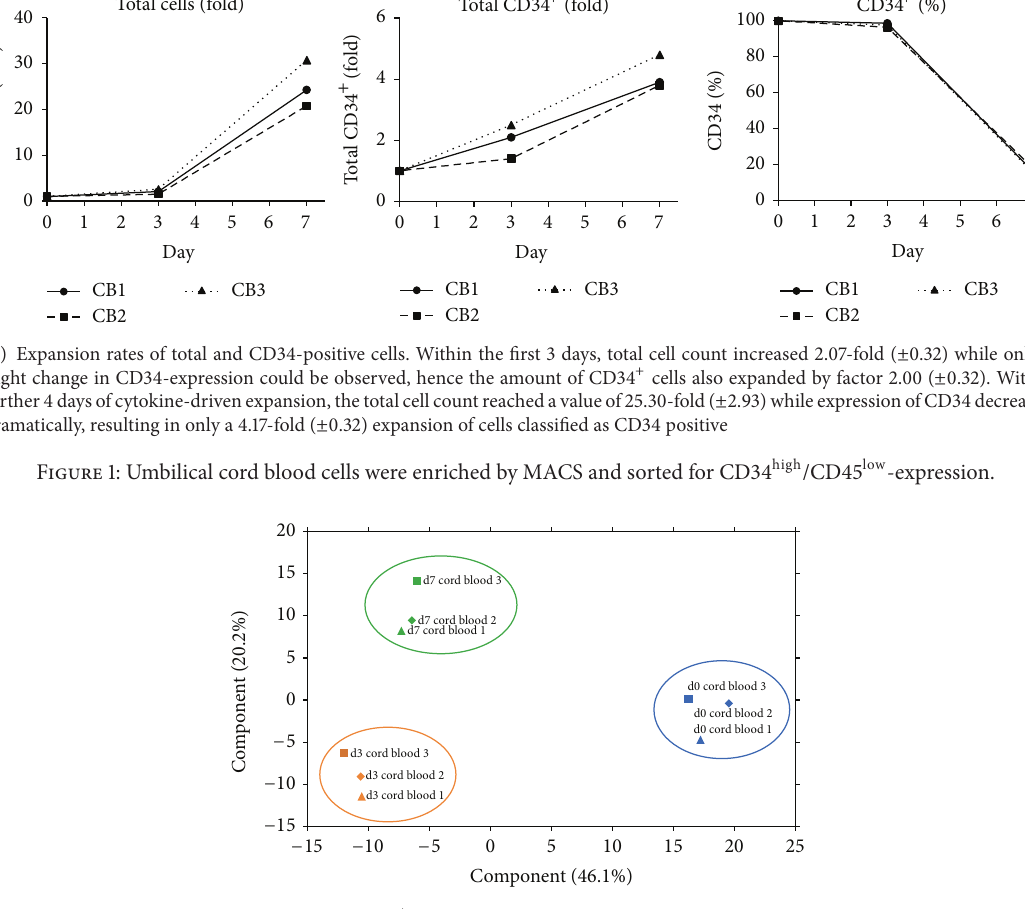
Figure 2: Principal component analysis (PCA) of CD34 + cells, showing that the three time points are distinct. Based on protein expression data, the largest variance was observed between day 0 and day 3; compared to this, the variation between day 3 and day 7 is smaller. Only little variances were observed between the three different cord blood